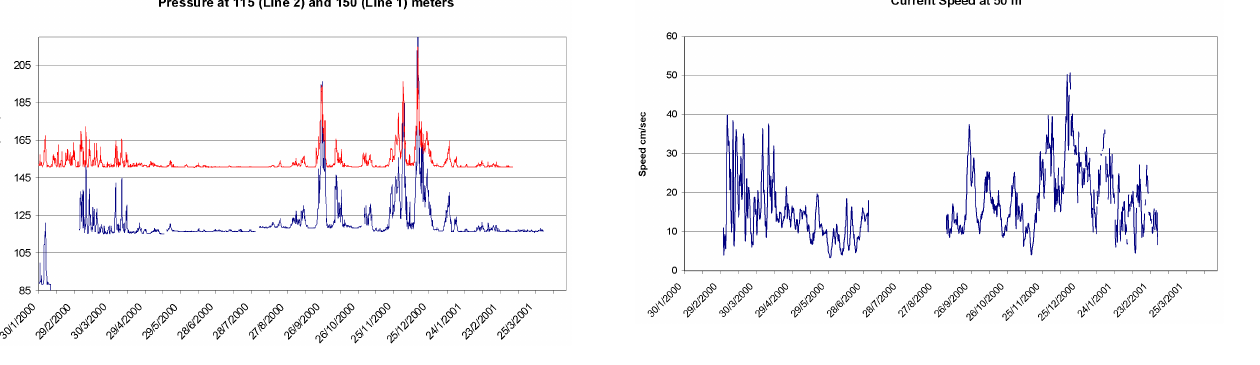
Fig. 6. Time series of pressure measurements for Line 1 (red) and Line 2 (blue).